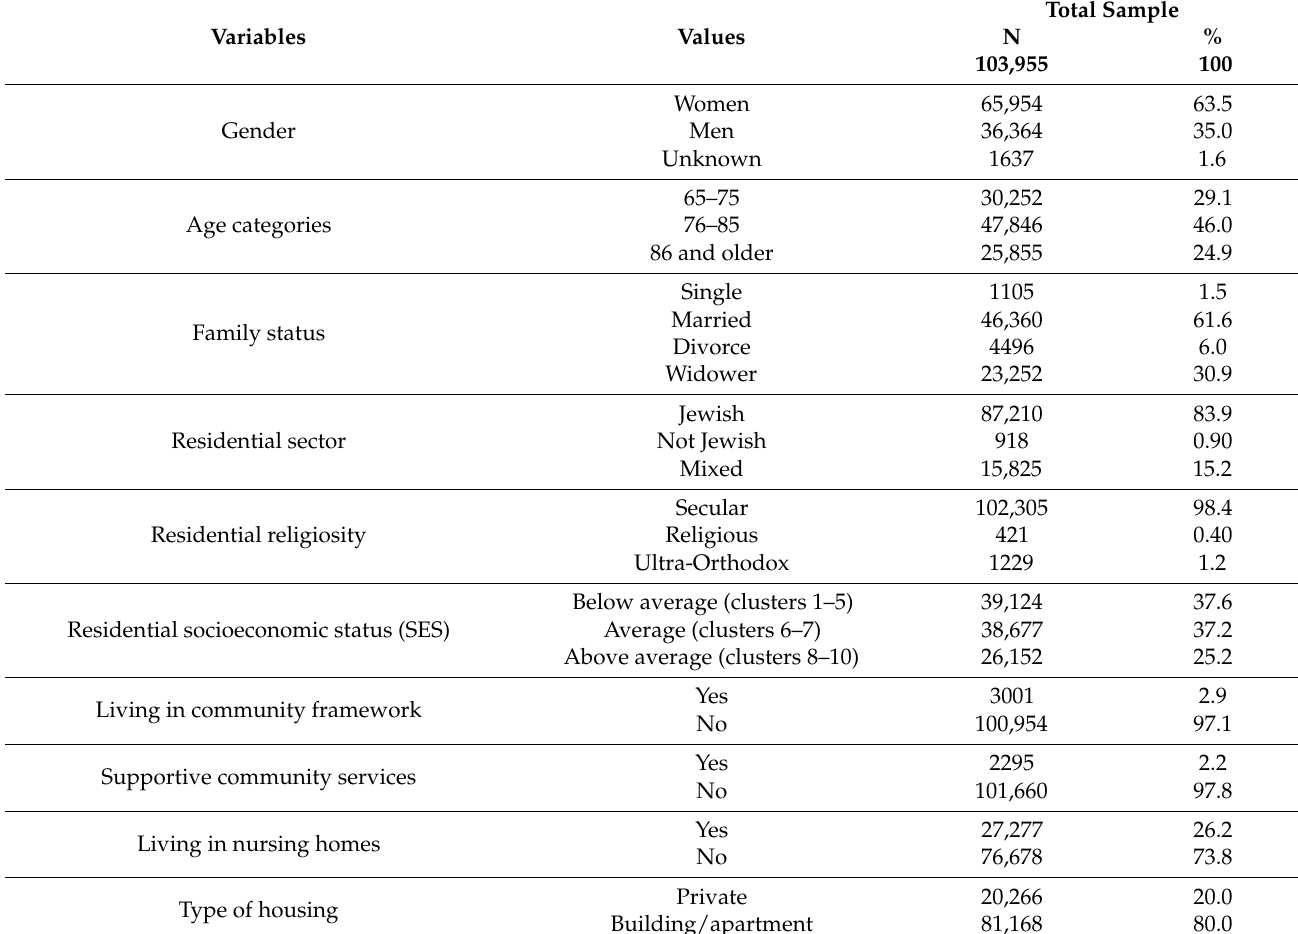
Table 1. Sample description by socio-demographic